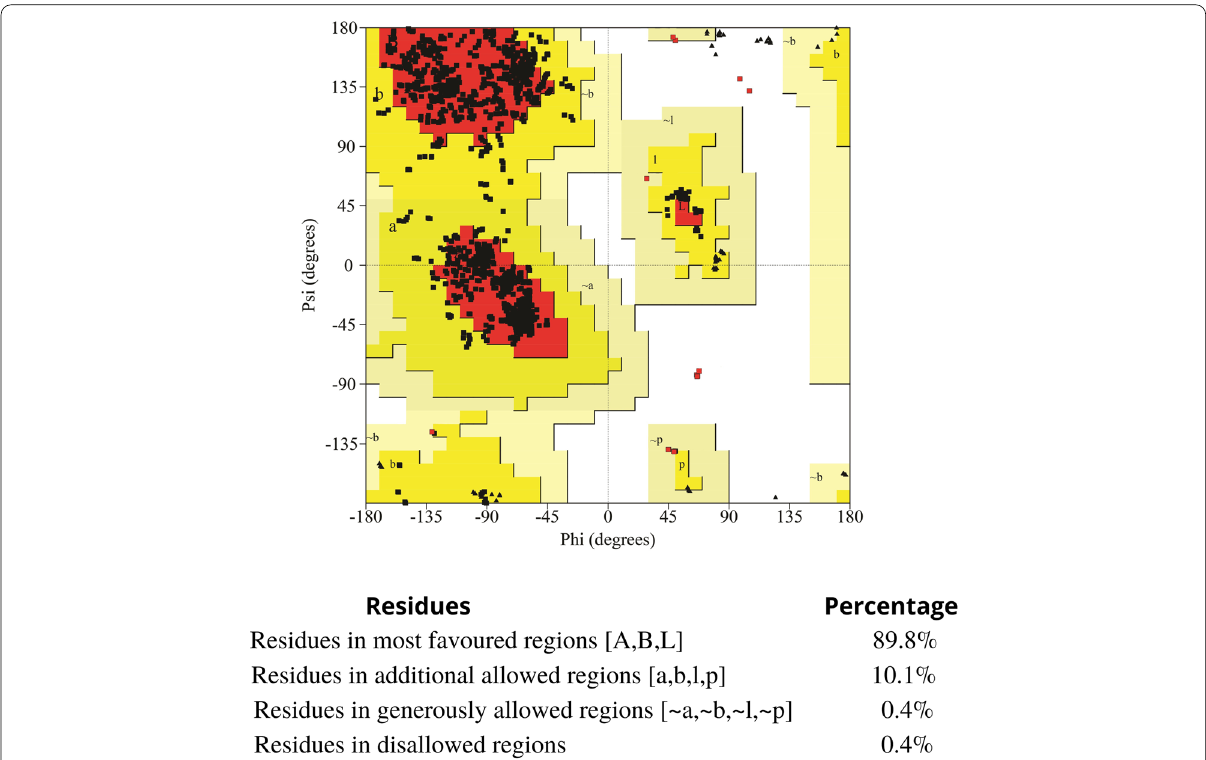
Fig. 5 Ramachandran plot of predicted CAT model from Arabidopsis thaliana generated from PROCHECK. Residues in most favored regions (A, B, L)—89.8%. Residues in additional allowed regions (a, b, l, p)—10.1%. Residues in generously allowed regions (~a, ~b, ~l, ~p)—0.4%. Residues in disallowed